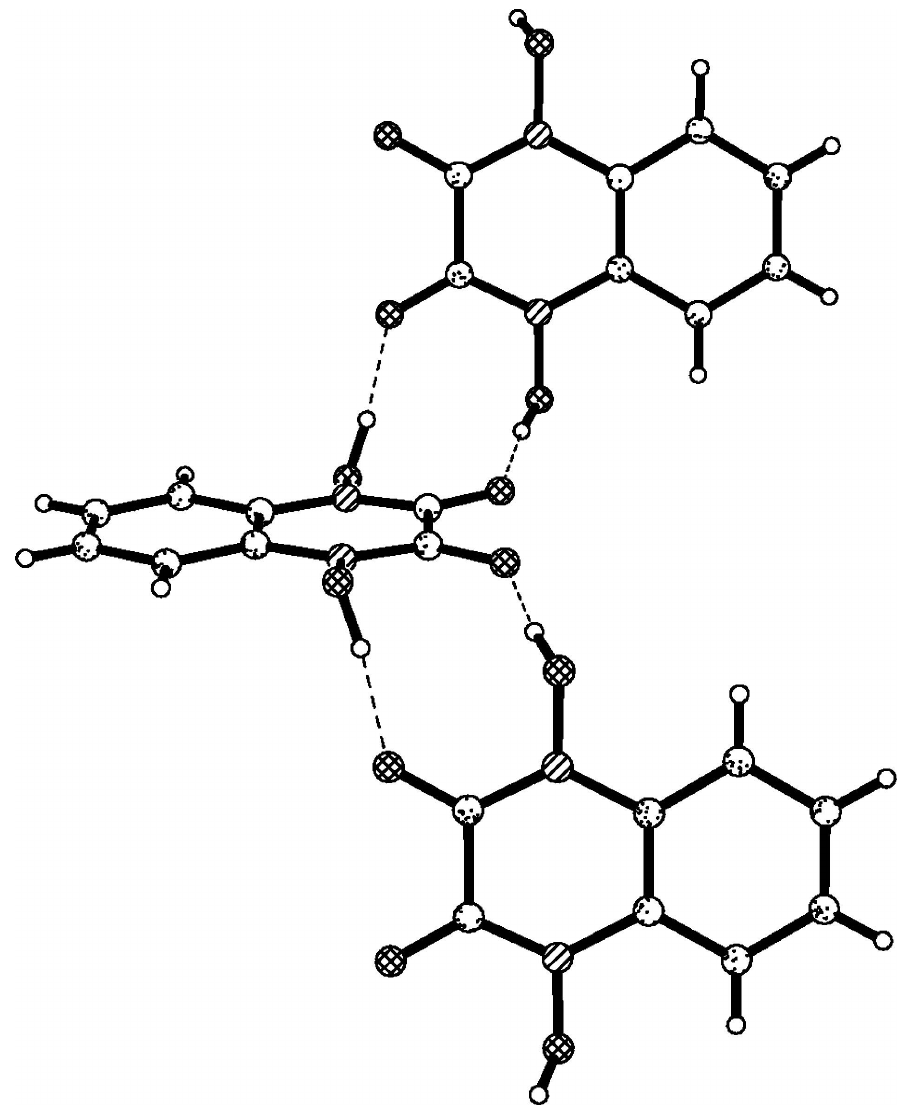
Figure 3 Part of the crystal structure of (I), showing the formation of R